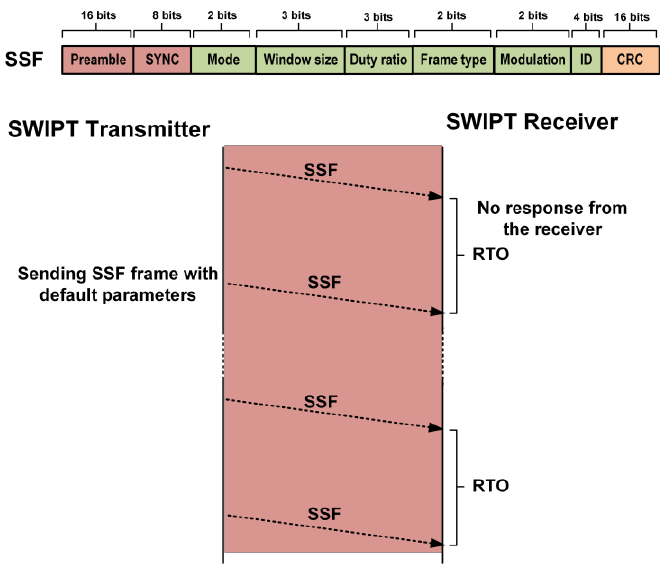
Figure 10. Transmission of the synchronization sequence frame (SSF) frame from the SWIPT trans-